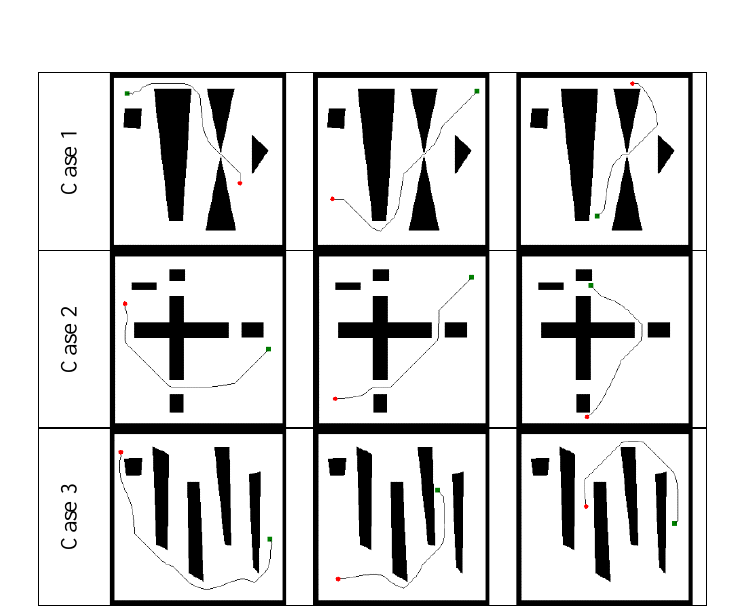
Fig. 3. The paths generated from different starting position (green dot/square dot) and target (red dot/circle dot) positions for various environment using proposed